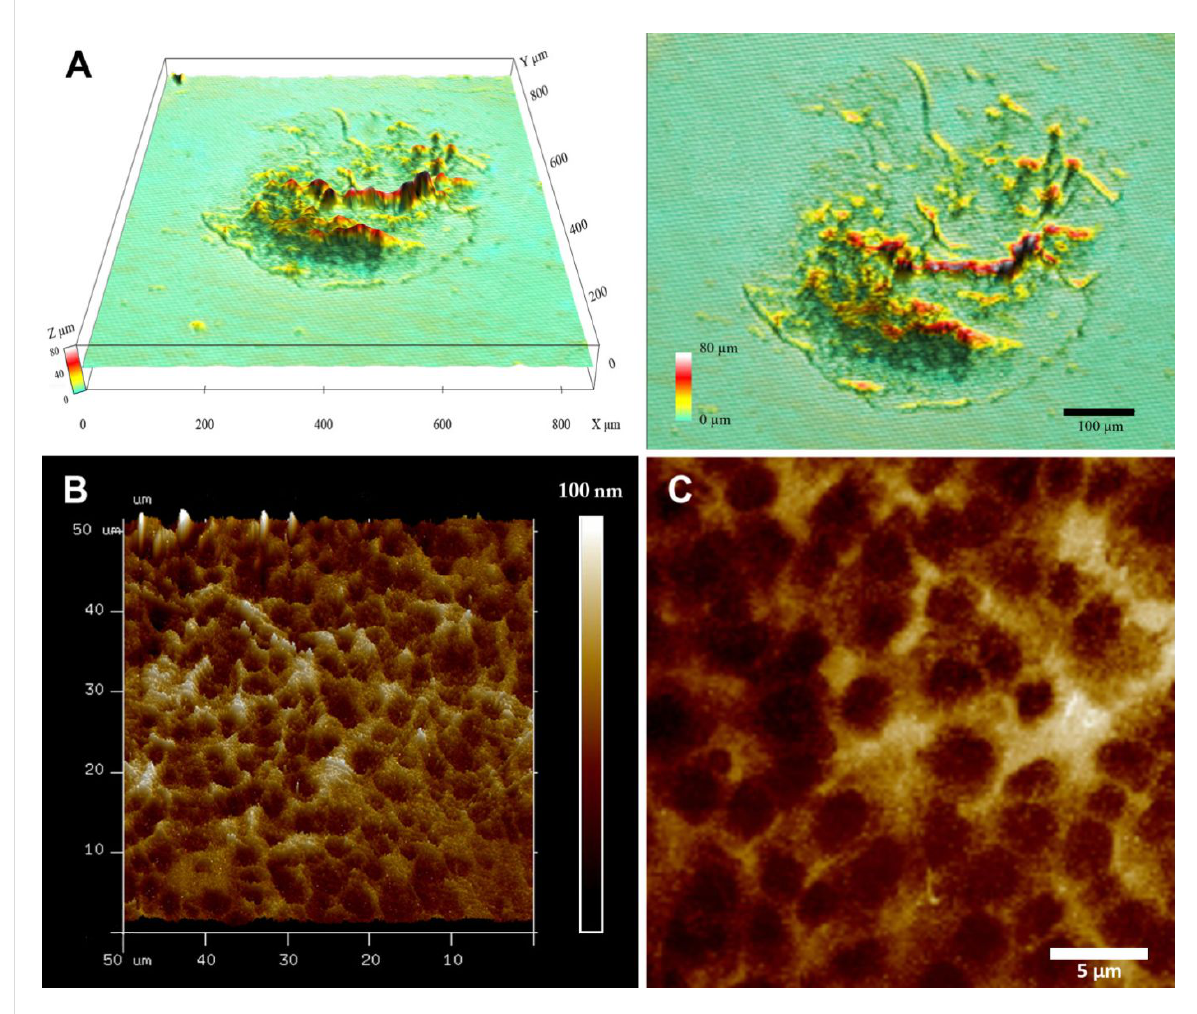
Figure 5: Topography of the footprints in A. gibbosa shown with 3D confocal interference microscopy (A) and AFM (B,C). (A) Overview of a footprint with 3D confocal interference microscopy in 3D and 2D. (B,C) AFM images of footprint meshwork in (B) 3D and at higher resolution in (C) 2D.